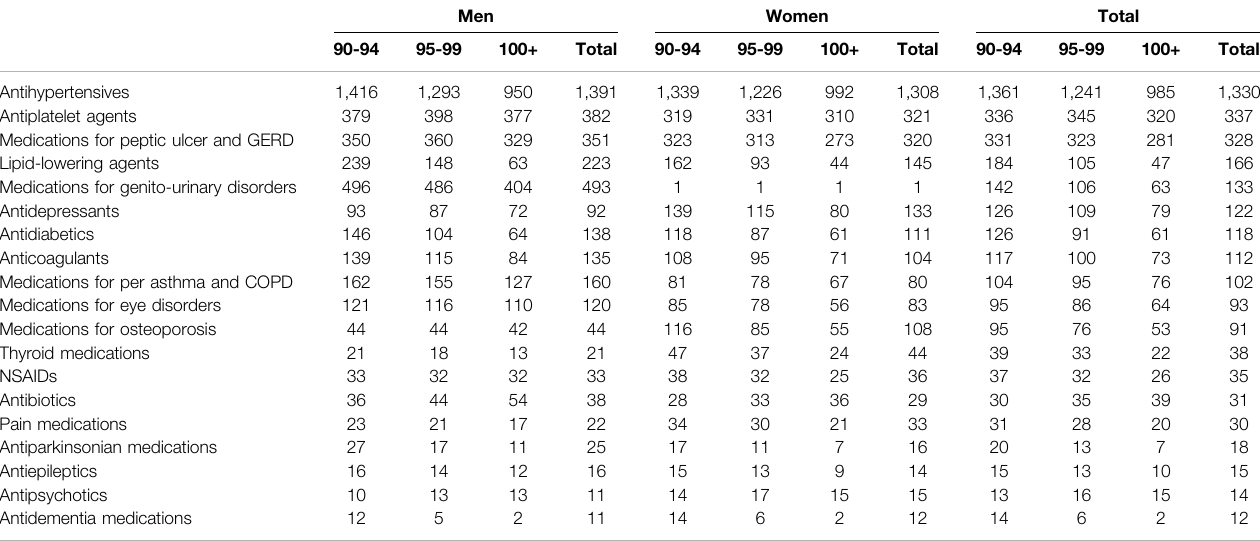
TABLE 2 | Consumption (DDD/1,000 inhabitants per day) by sex and age-group (2019) for pharmaceutical